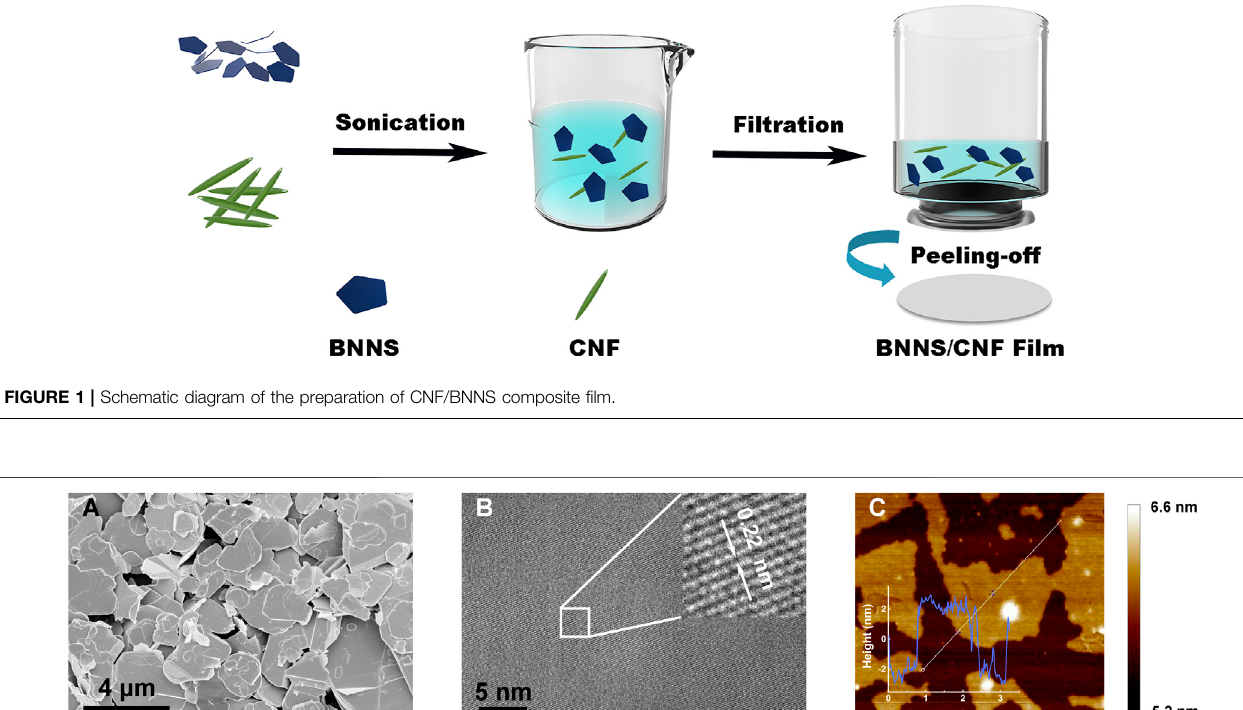
Frontiers in Materials |